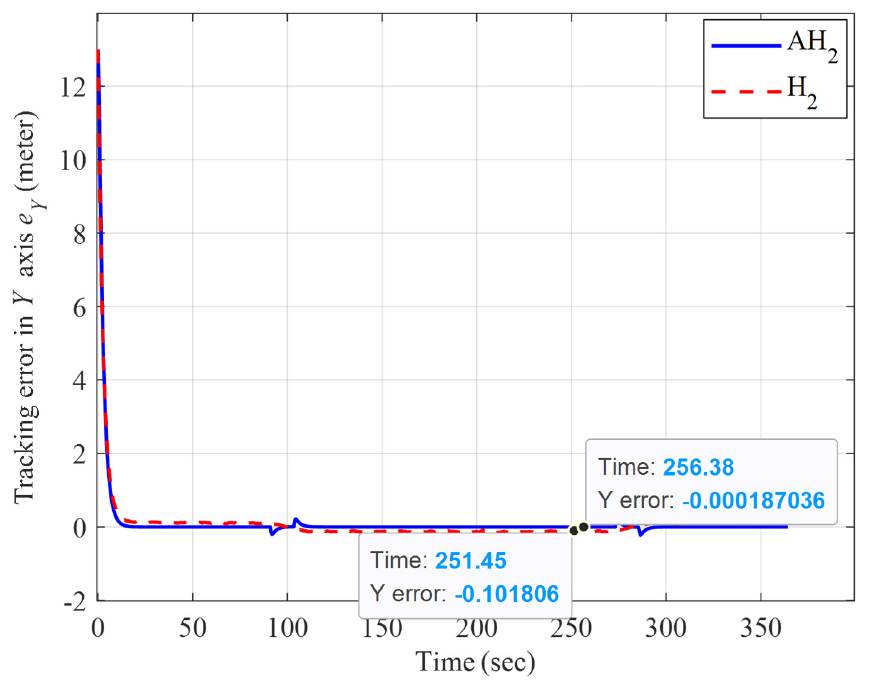
Figure 6. The square trajectory tracking result of the adaptive H 2 closed-form and H 2 closed-form control approaches for the y -axis from x p = 7 m, y p = 7 m.